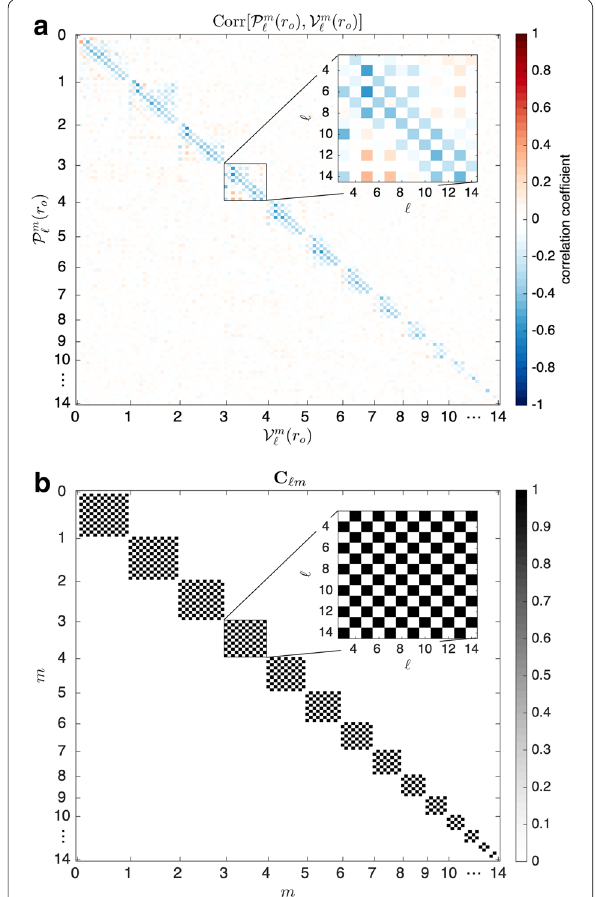
Fig. 12 Same as Fig. 1 but for correlations between the poloidal field potential and the poloidal flow potential near the CMB and the corresponding C ℓ m